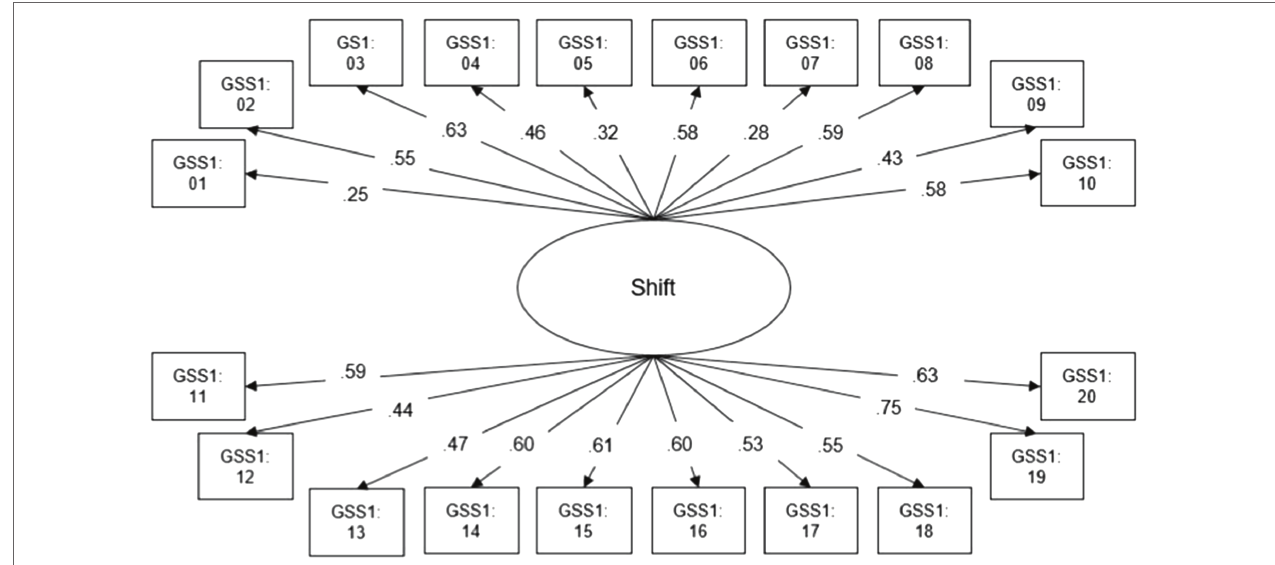
FIGURE 2 | Measurement model (completely standardized solution) for 20 Shift items of a German online GSS